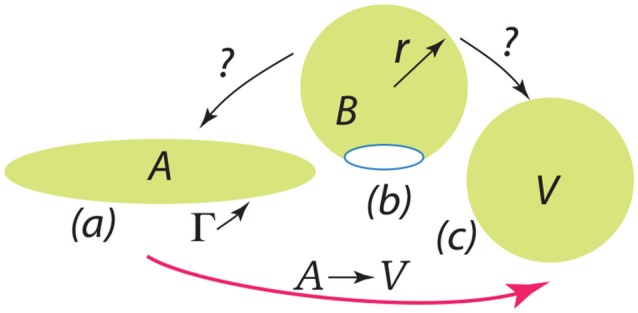
The depiction should be interpreted as follows: a bud (B) is released as in (b) and may revert to a flat patch (A) as in (a) or may close to form a spherical vesicle (V) as in (c).